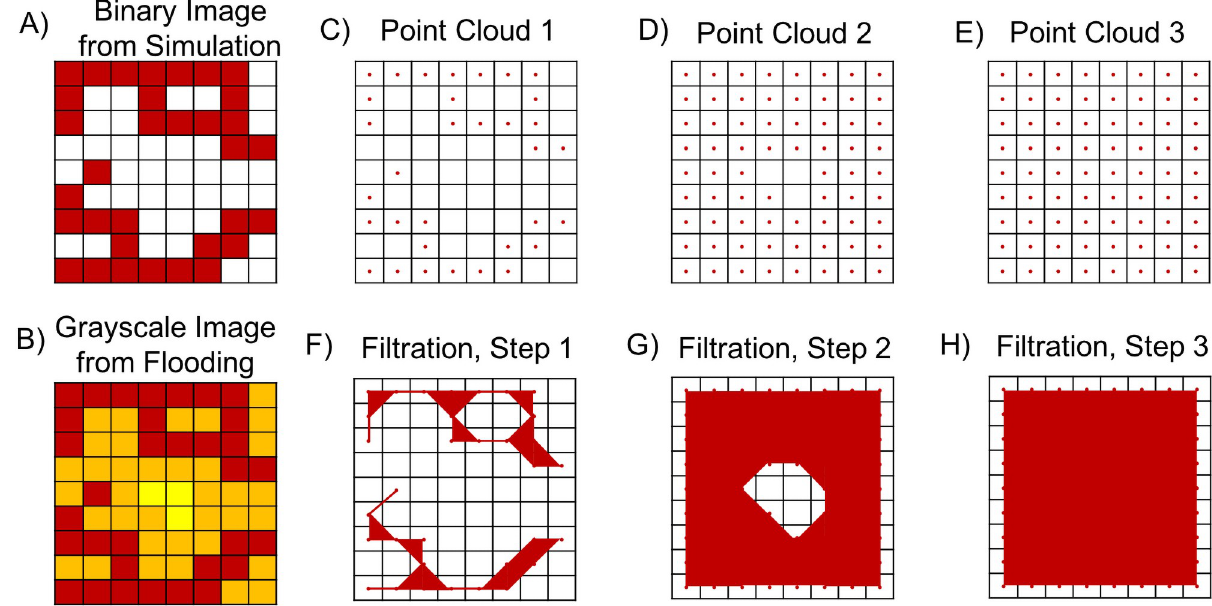
Fig 6. The flooding filtration for a binary image. A) Schematic binary image. B) Grayscale image of the original binary image. Red pixels are nonzero in the initial image, orange pixels become nonzero after one round of flooding, and yellow pixels become nonzero after two rounds of flooding. C-E) We performed three filtrations by dilating the image twice. During each filtration, the eight neighboring pixels of all nonzero pixels (ie pixels not marked as white) become nonzero. Red pixels are nonzero in the original image, orange pixels become nonzero on the second filtration (i.e., after one step of flooding), and yellow pixels become nonzero on the third filtration (i.e., after two steps of flooding). F-H) Simplicial complexes associated with the filtrations presented in panels